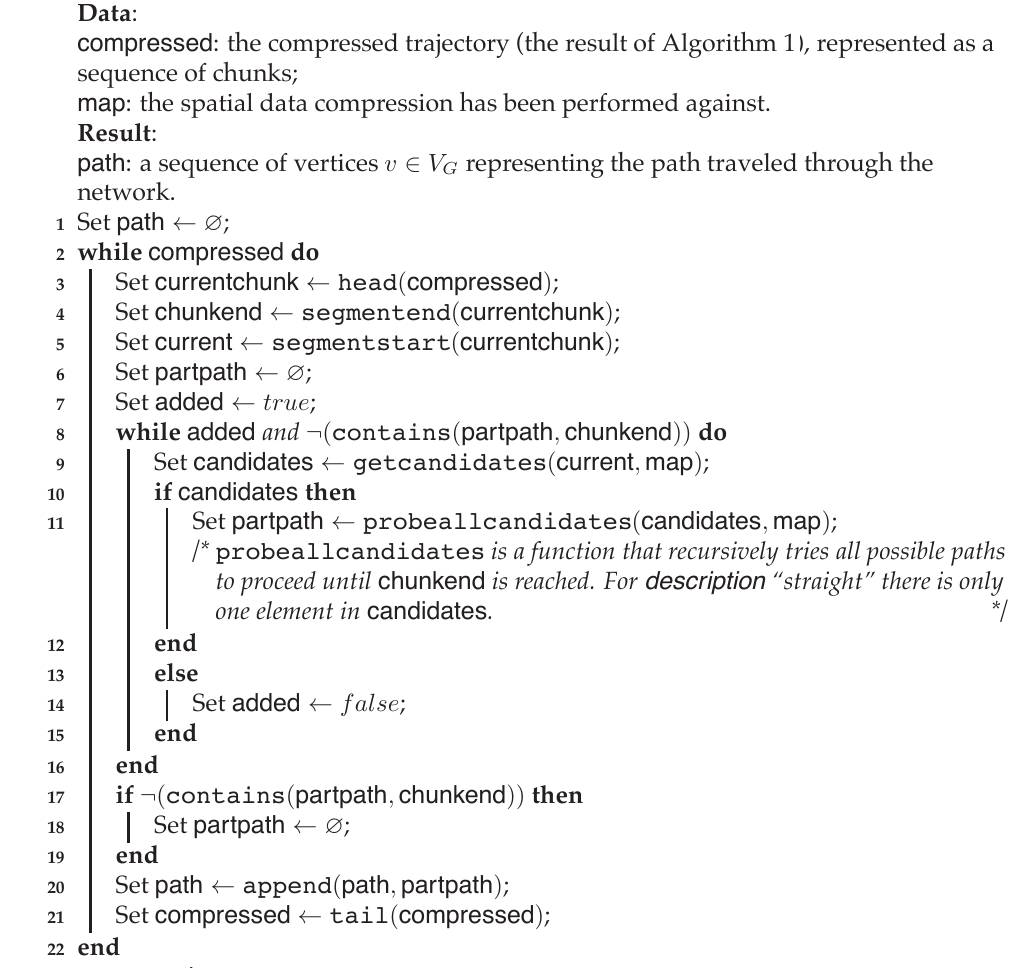
Algorithm 2: The decompression